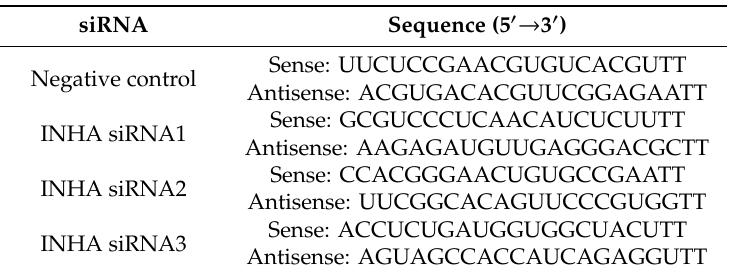
Table 2. INHA siRNA sequences.